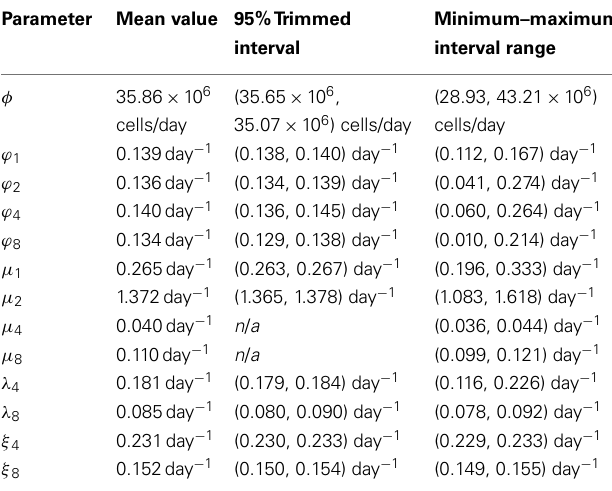
Table 2 | Means, 95% trimmed and minimum–maximum intervals of the model